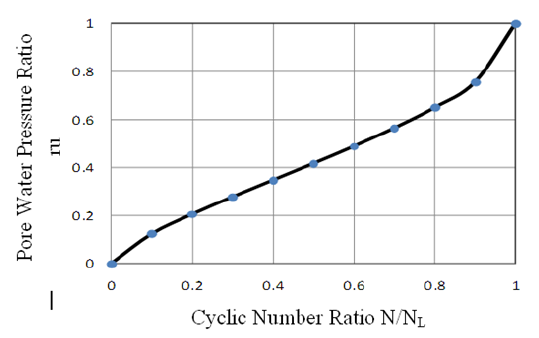
Figure 3. Cyclic number ratio N/NL versus pore pressure ratio ru (Seed and Booker, 1977) [17].